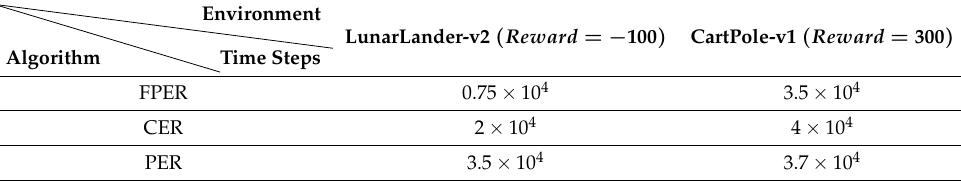
Table 1. Implemented time in discrete control tasks.